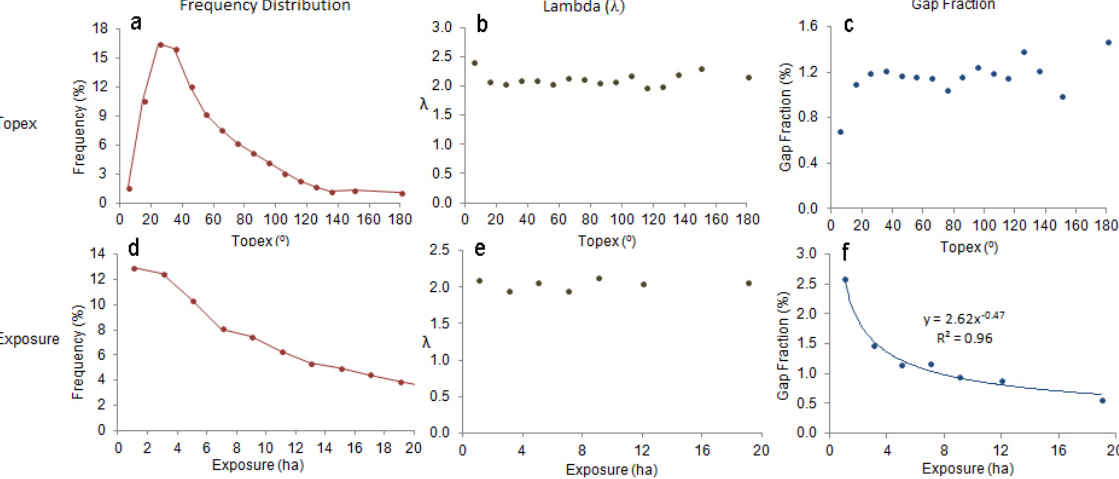
Fig. 6. Effect of topographic exposure on the gap size-frequency distribution ( a,d ), the frequency distribution of exposures (b,e) and the gap area fraction (c,f) calculated using two indices of exposure: topex (upper panels) and total visible area (lower panels). 620